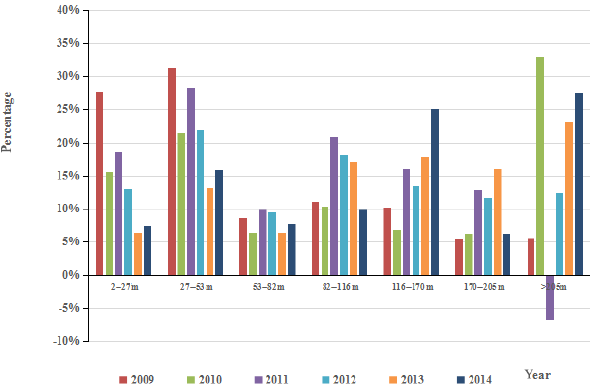
Figure 5. Histogram of the annual layered compression ratio of monitoring station A